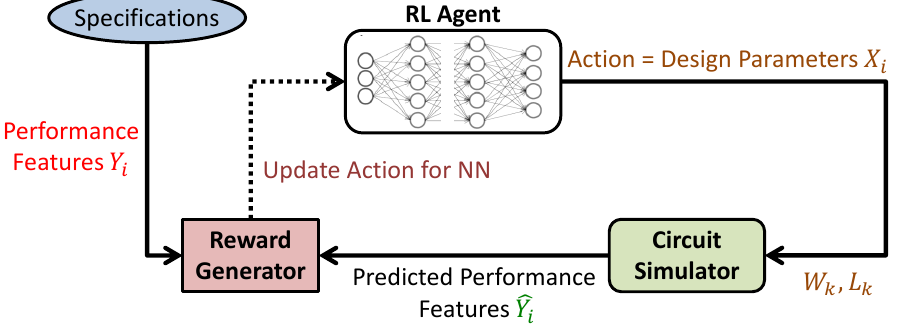
Figure 5. Reinforcement learning design flow as applied to analog IC design